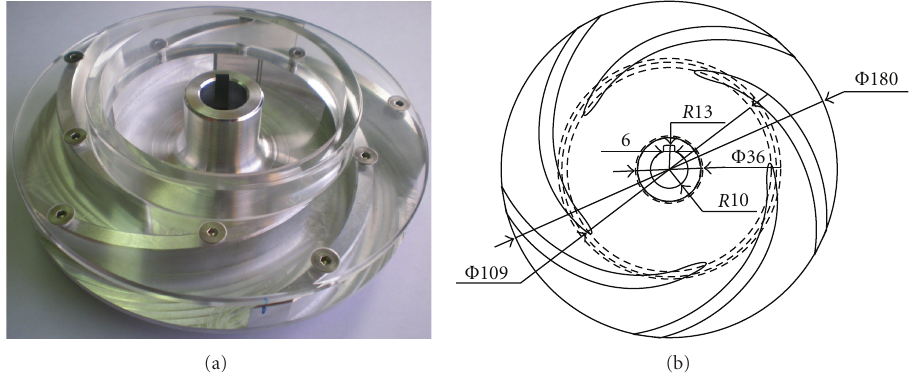
Figure 3: The examined impeller geometry and the scaled drawing (in mm) with blade leading edge angle of 9deg.